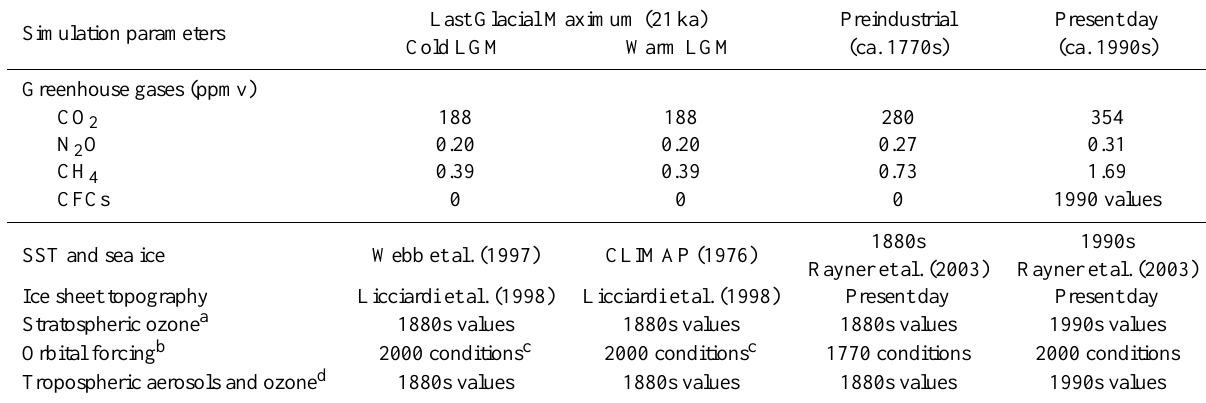
Table 2. Climate forcings used in GISS ModelE for each climate scenario.